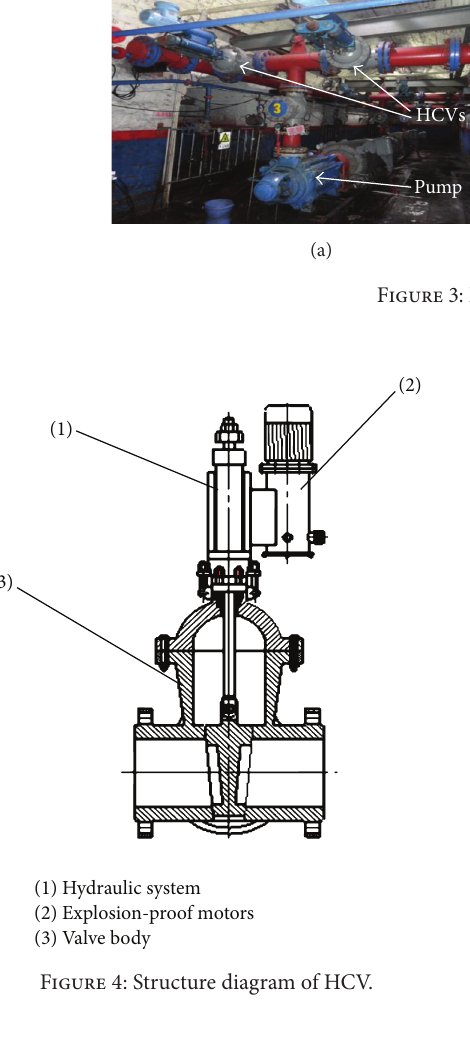
Figure 4: Structure diagram of HCV.